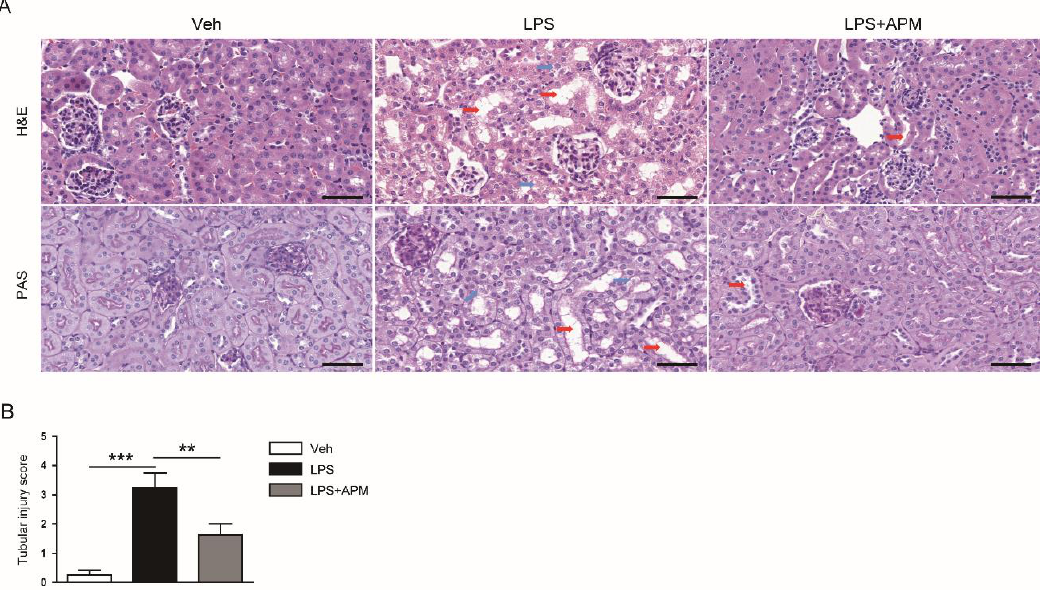
Figure 2. Histological examination of kidneys from all experimental groups. ( A ) Hematoxylin and eosin (H&E) and periodic acid Schiff (PAS) staining of kidney tissues. Red arrows indicate dilated tubules. Blue arrows indicate swelling of tubular epithelial cells. Scale bars: 50 μm. ( B ) Tubular injury score. n = 8 per each group. ** p < 0.01 and *** p < 0.001.